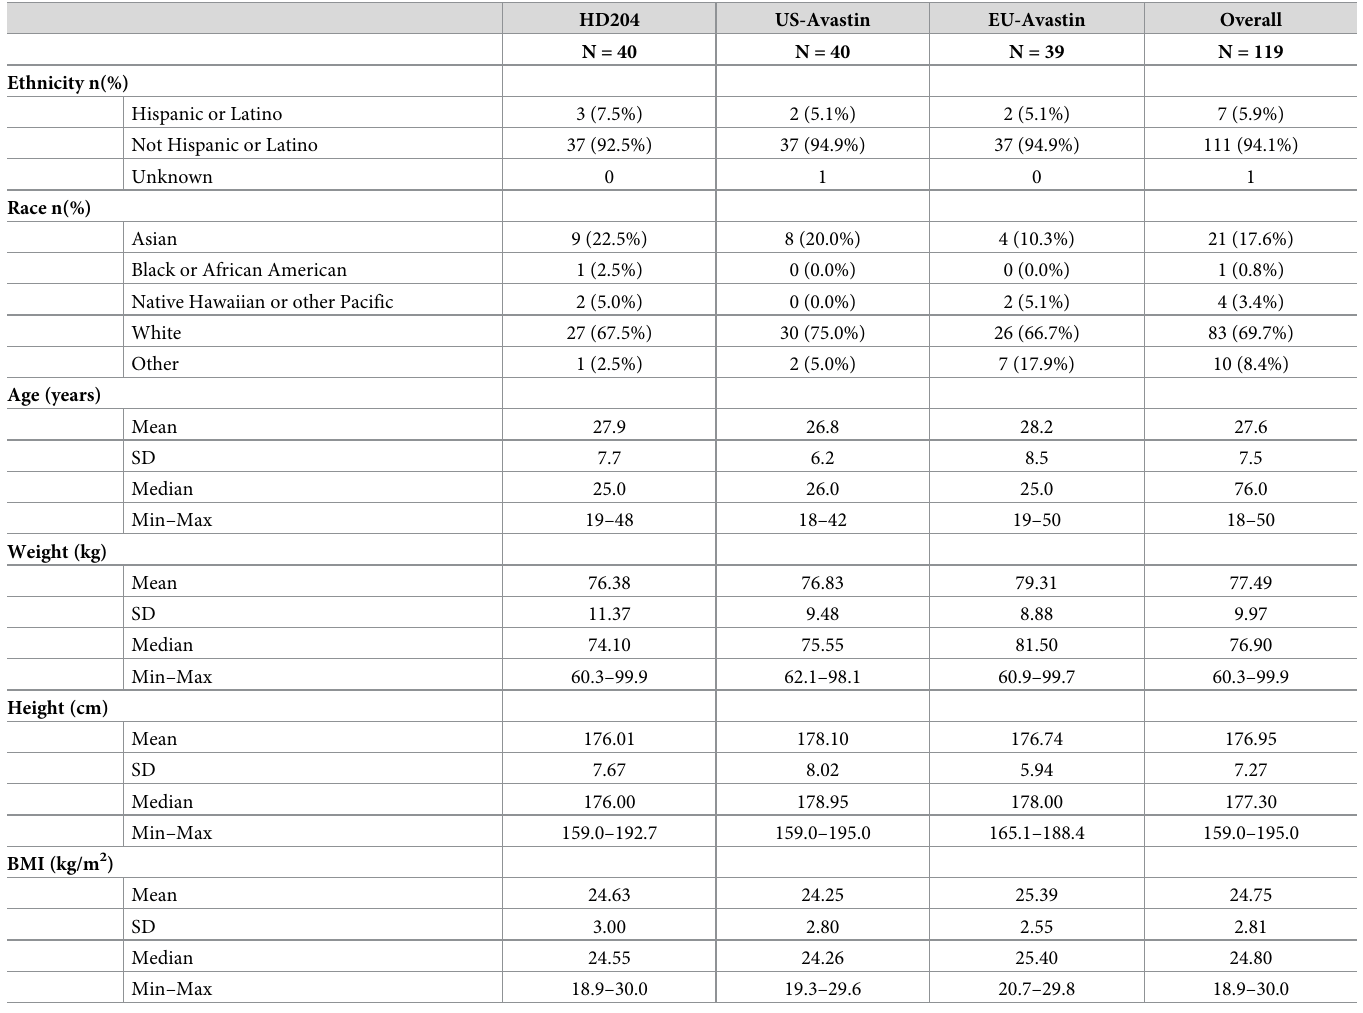
Table 1. Demographic data (SA